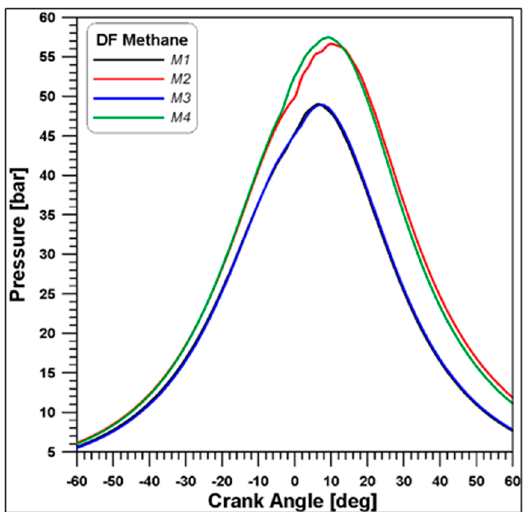
Figure 1. Experimental in-cylinder pressure. Cases with methane.